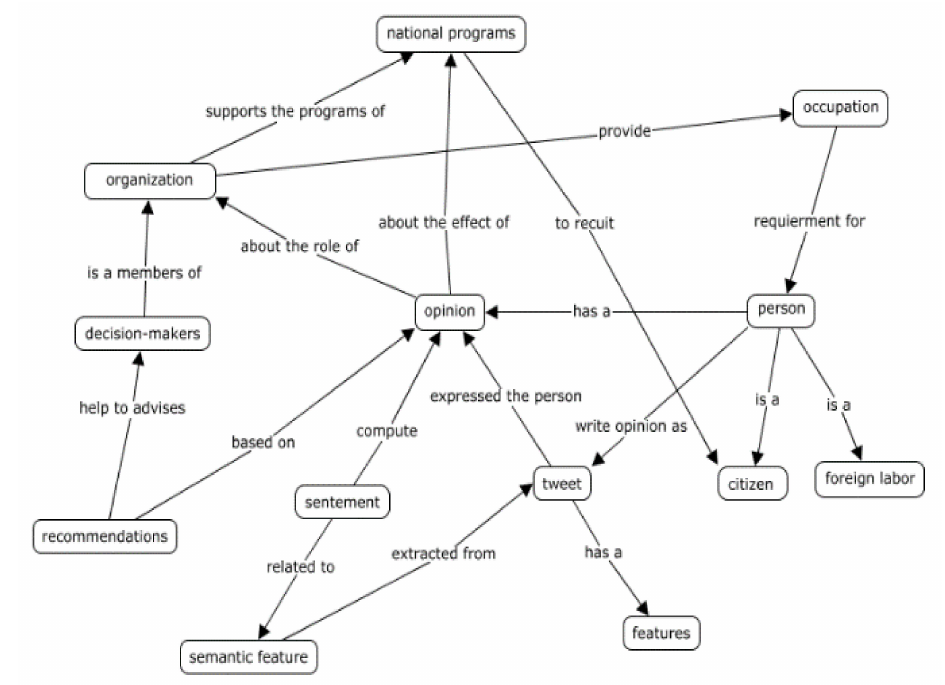
Figure 1. Concept